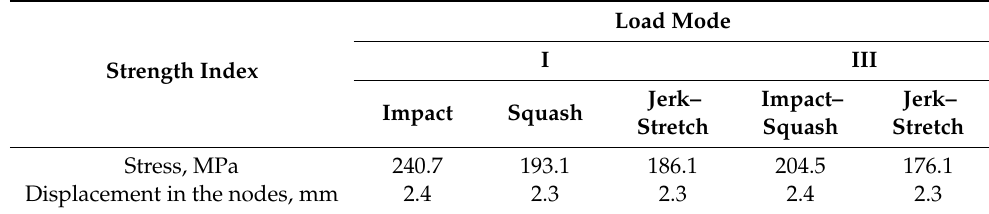
Table 1. Results of calculation of the hopper wagon.